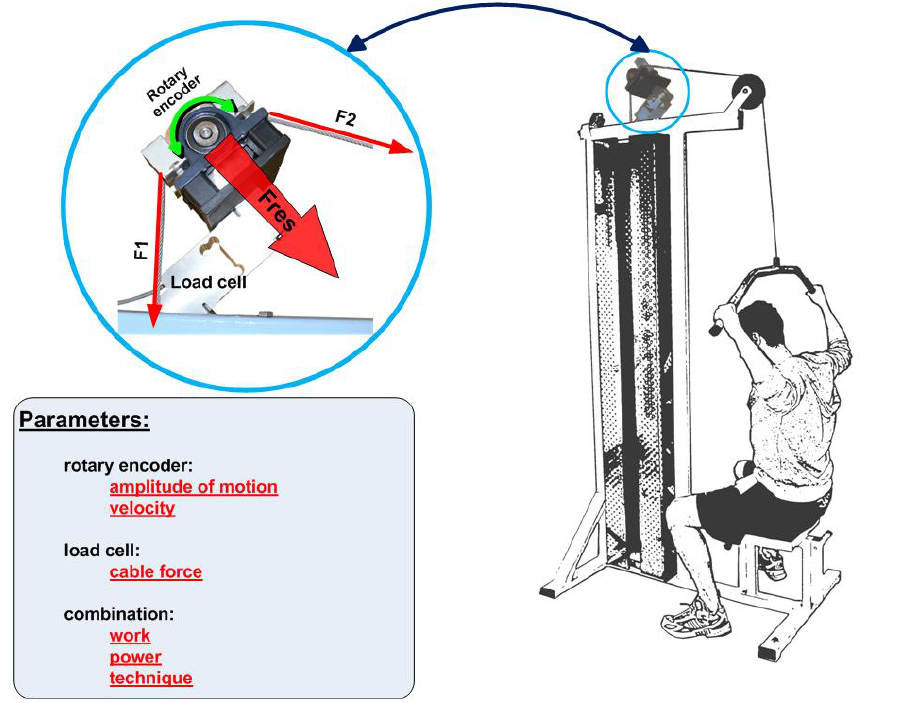
Figure 11. Implementation of a load cell and a rotary encoder into an exercising